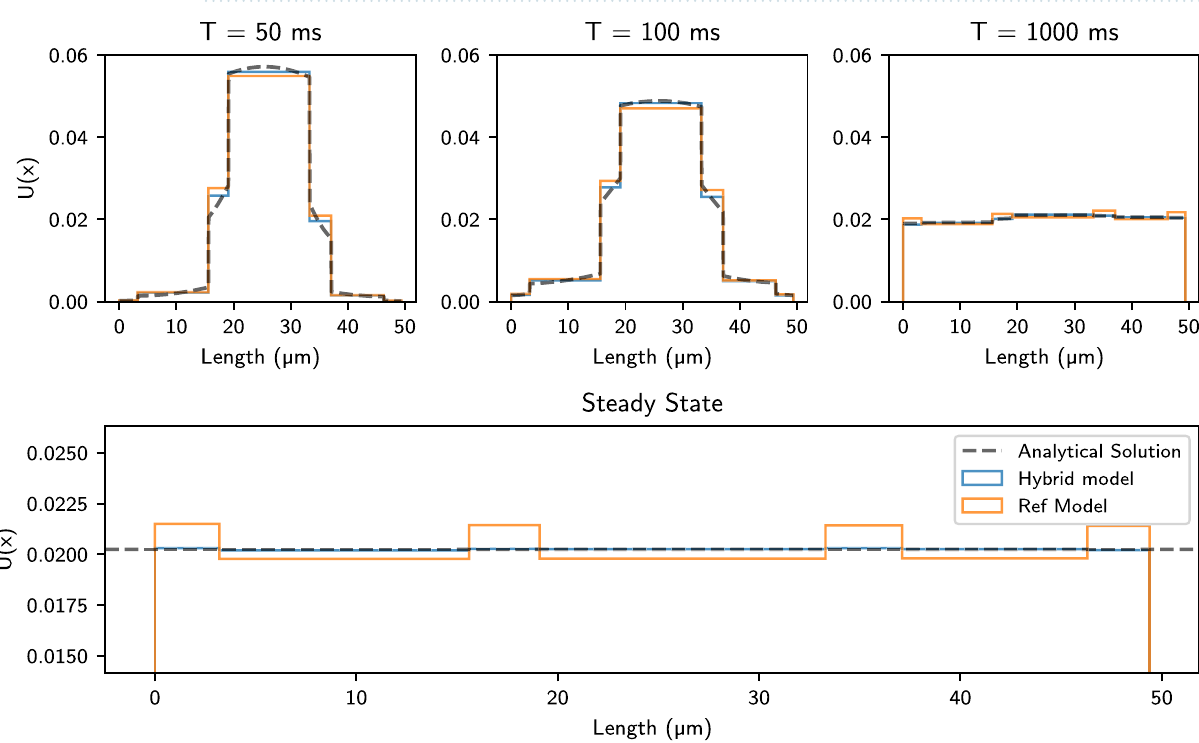
10 6 walkers and a time step of δ t 1.5ms . Top: Figure 7. Analytical and random walk solutions using N p = = x 0 ) for initial concentration at x 0 located in the centre of the domain considering Transient solution U ( x , t ; three simulation times 50, 100and 1000 ms . Bottom: Steady-state solution obtained after uniformly seeding the 1000ms . The reference model results in accumulation walkers in the domain. The simulation time is set to T = of walkers in ECS compartments. Note that this effect is visually amplified by the choice of axis data